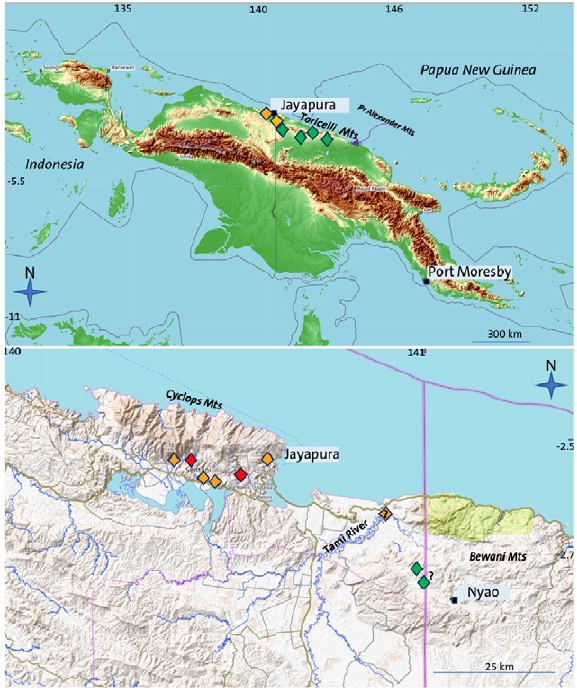
Figure 2. Dineutus helleri . Distribution overview of localities in New Guinea (above) and focus on the Jayapura area (below). Din- eutus helleri helleri = green diamonds; D. helleri stueberi published localities = orange; D. helleri stueberi new localities = red. Map generated using the OpenTopoMap layer in gps visualizer (https:// www.gpsvisualizer.com/) and edited using Microsoft